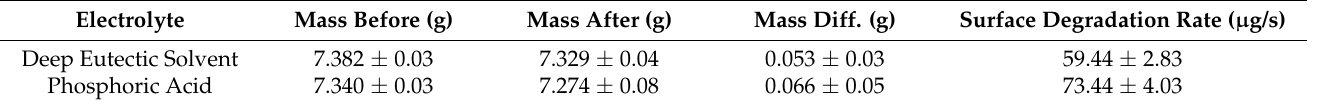
Figure 2. Linear sweep voltammograms ( A ) for both electropolishing mediums with copper samples stepped from 0 to 3 V at a constant scan rate of 20 mV/s at 70 °C. The dashed line indicates the ideal voltage utilized for ( B ) chronoamperometry for phosphoric acid (0.33 A/cm 2 ) and the deep eutectic solvent eutectic (0.06 A/cm 2 ) with high-purity copper samples. Both figures feature samples collected every 5 s, and the working potential of 1.5 V was selected based upon the stabilized local minima, noted as the gray line in A. Table 1. Average copper electropolishing rate (µg/s) calculations for five samples with a potential of 1.5 V in each medium at 70 °C over a 900 s treatment.